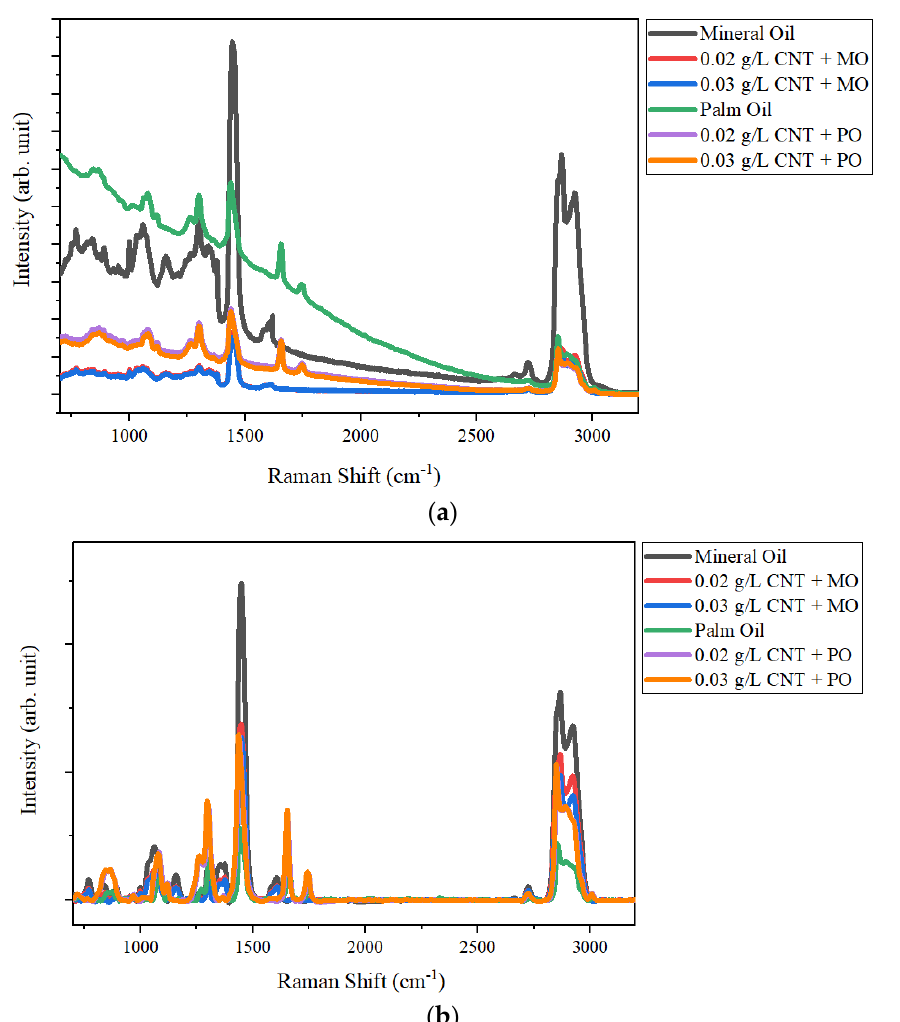
Figure 2. Raman spectrum of oil sample ( a ) before the pre-processed ( b ) after the pre-processed operation.